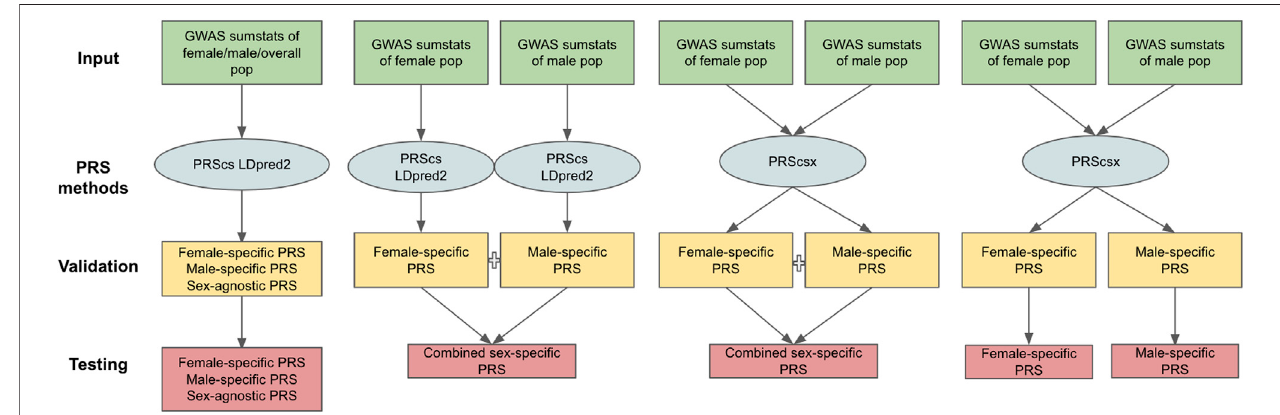
FIGURE 1 | Overview of the 11 PRSs considered. The inputs are female-speci fi c GWAS summary statistics, male-speci fi c GWAS summary statistics, and sex- agnostic GWAS summary statistics; PRS methods include PRScs, LDpred2, and PRScsx; validation samples are used to tune hyperparameters of PRSs and fi nd the optimal weights of sex-speci fi c PRSs; testing samples are to assess prediction